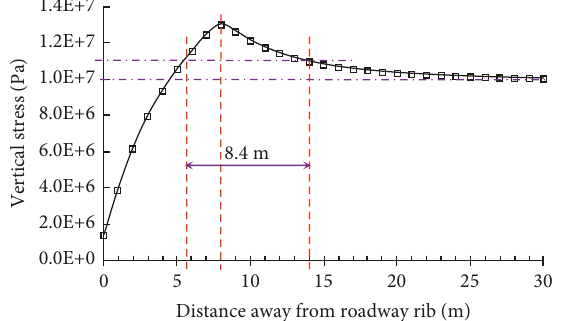
Figure 14: The vertical stress distribution inside the roadway rib.